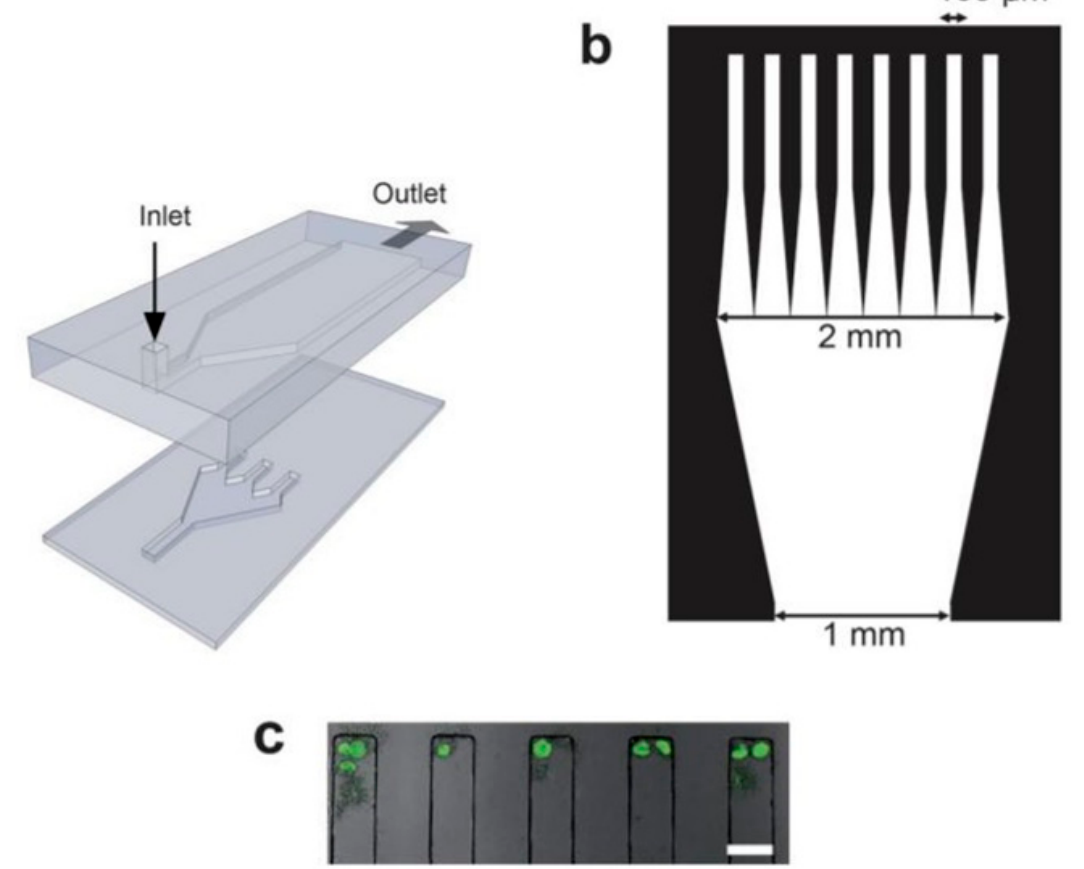
Figure 3. ( a ) Microfluidic device in which two PDMS channels facing each other are sealed together [14]. ( b ) Diagram of the chambers along with the channel dimensions. ( c ) Image of Arcella incubated with fluorescein diacetate in capture chambers. Adapted with permission from [14]. Copyright 2009 Copyright Royal Society of Chemistry.